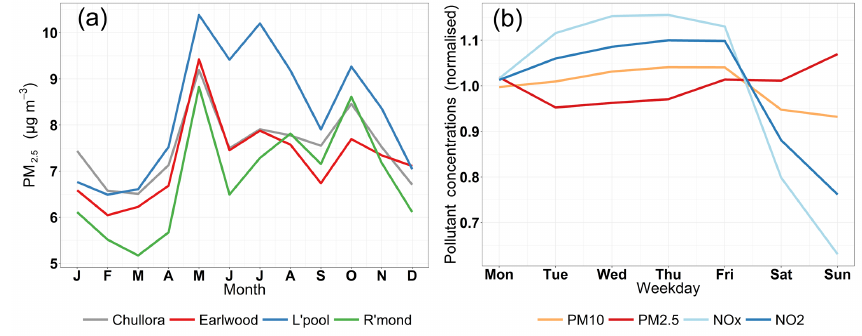
Figure 5. Mean monthly PM 2 . 5 concentrations for the period 2005 to August 2016 at four air quality monitoring sites in Greater Sydney (a) . Southern Hemisphere seasons are summer (DJF), autumn (MAM), winter (JJA) and spring (SON). Mean daily normalised concentrations of PM 2 . 5 compared to the variations of PM 10 , NO 2 and NO x (b) . Table 2. Adjusted R 2 , F and p values for the smoothers of the optimal generalised additive mixed models (GAMMs) applied to each monitoring site on days when hazard reduction burns occurred and with the data split into low and high air pollution conditions. Pollution Chullora Earlwood Liverpool Richmond Condition